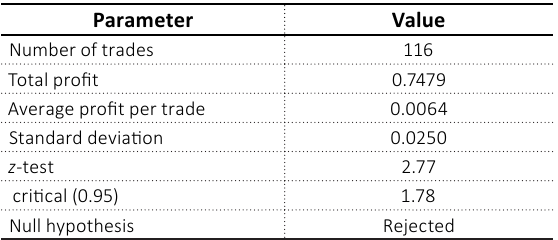
Table 6. Z -test of the trading strategy based on price gap anomaly: the case of the